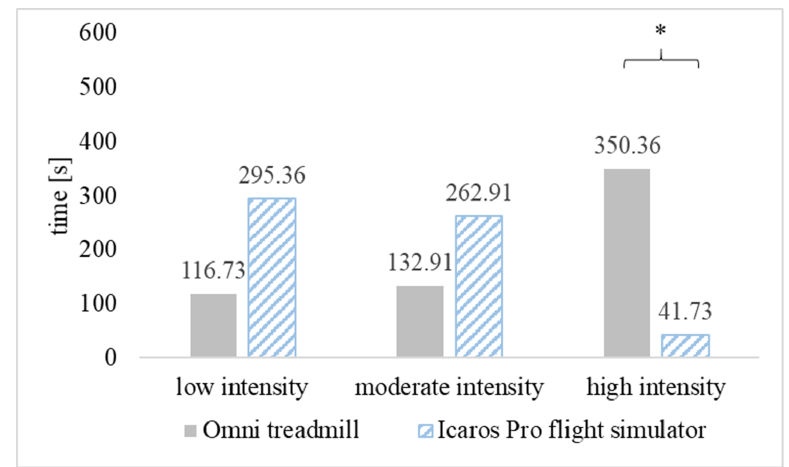
Figure 3. The average intensity of physical effort during active video games (AVGs) in VR on the Omni treadmill and Icaros Pro flight simulator, * p < 0.01.